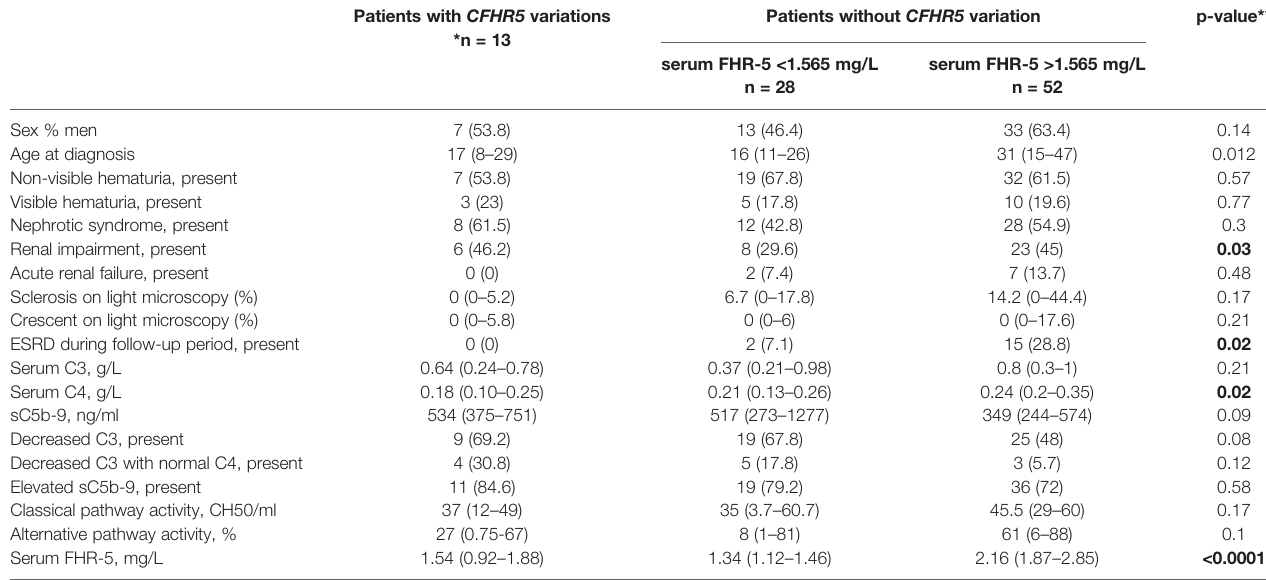
TABLE 4 | Presenting clinical and laboratory characteristics of patients with or without CFHR5 variations, strati fi ed according to FHR-5 serum levels. Patients with CFHR5 variations *n = 13